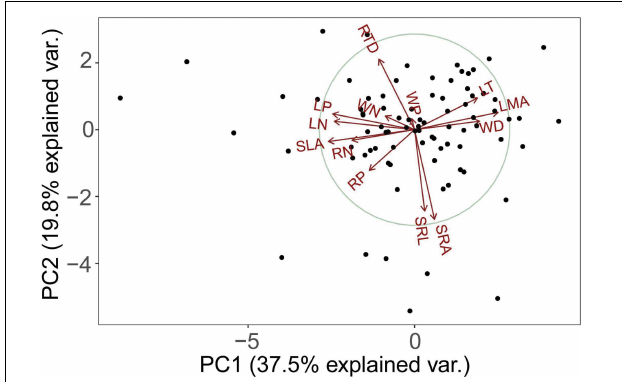
FIGURE 1 | Principal component analysis (PCA) using average trait values from 84 tree species in the tropical cloud forest. See Table 1 for trait abbreviations.